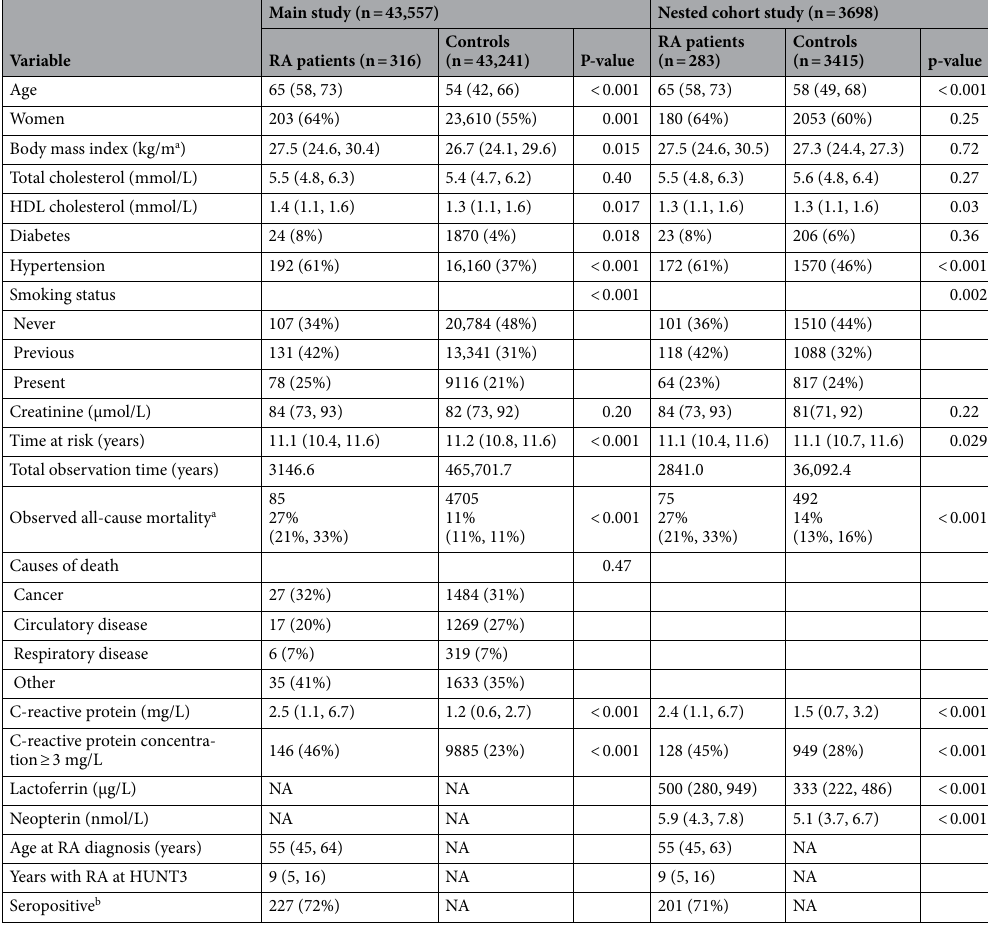
Table 1. Participant characteristics. Data are given as number (%) or median (25th, 75th percentile). RA patients and controls were compared using the Chi-square test or Mann–Whitney U-test. HDL, high-density lipoprotein; HUNT3, 3rd wave of the Trøndelag Health Study; NA, not applicable; RA, rheumatoid arthritis. a 95% confidence intervals in parenthesis, calculated using the binomial distribution. b Seropositive: Positive for IgM rheumatoid factor and/or anti-citrullinated protein peptide